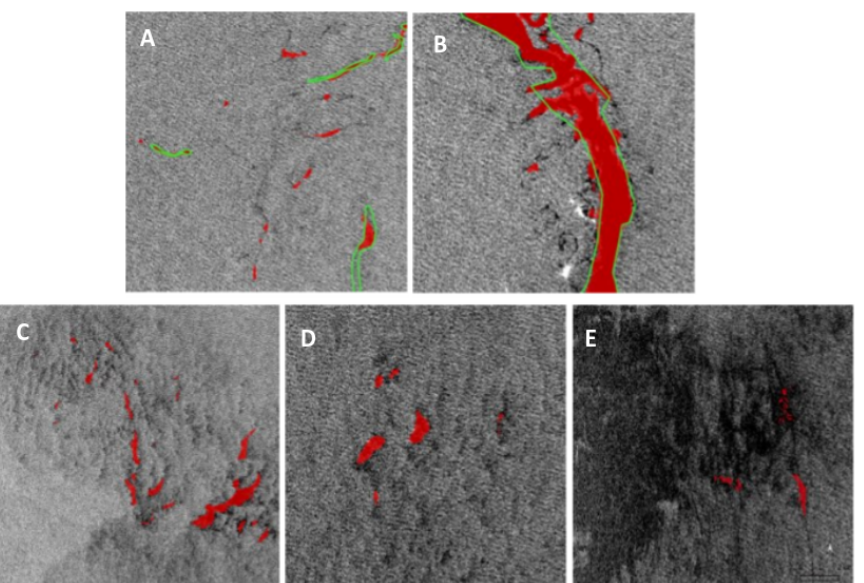
Figure 19. False alarm samples for the improved baseline version of the FC-DenseNet model ( T SAR ). False alarms are marked in red and slick annotations are marked with green polygons. ( A , B ) represent false alarms around a slick, and ( C – E ) represent other false